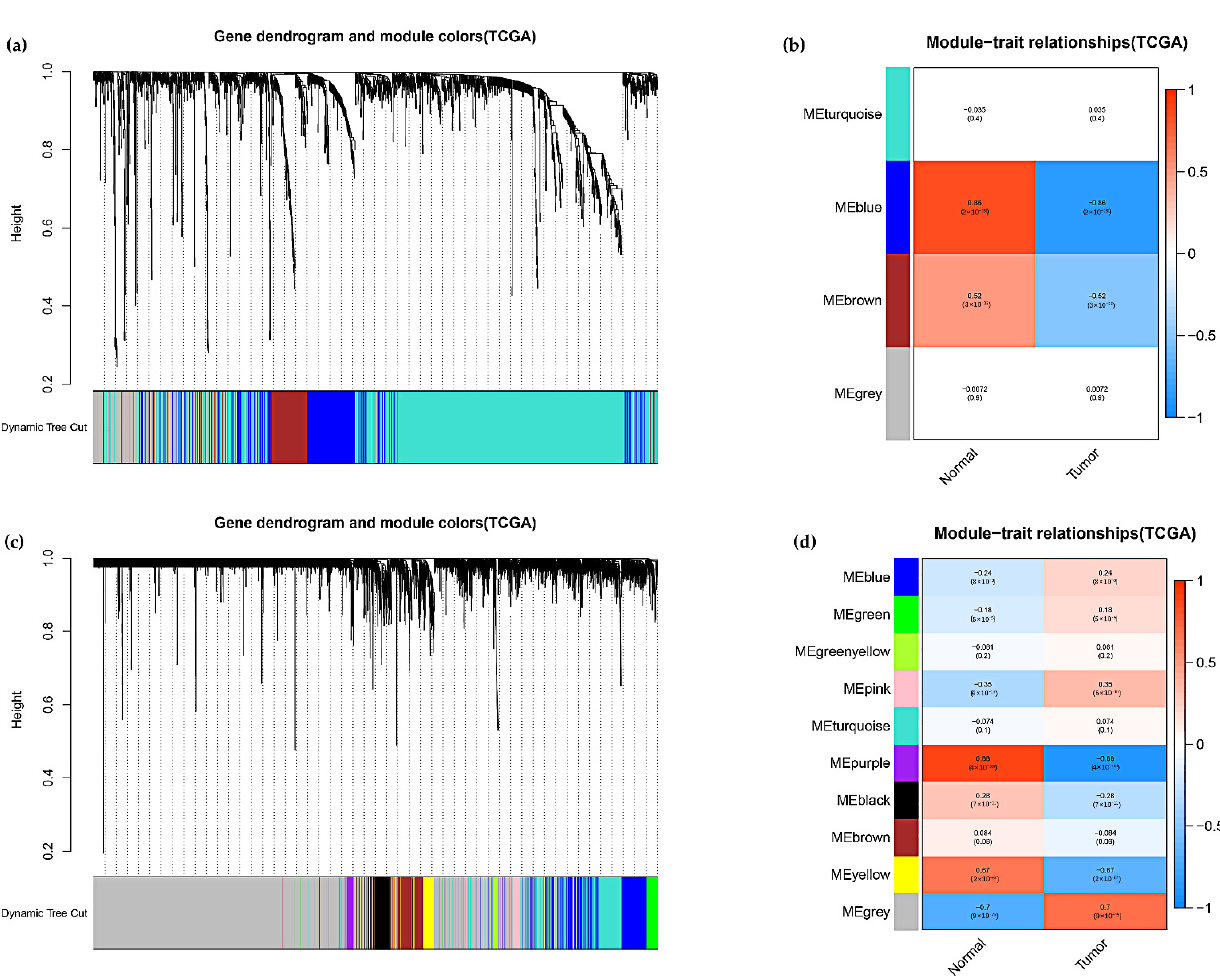
Figure 7. Screening for modules significantly associated with colon adenocarcinoma by WGCNA. ( a ) Hierarchical cluster analysis of the identified lncRNAs was performed to detect co-expression clusters with corresponding color assignments. ( b ) Correlation analysis of clinical features of colon adenocarcinoma with Eigengene of lncRNAs, where MEblue had the highest correlation coefficient. ( c ) Hierarchical clustering analysis of the identified mRNAs. ( d ) Correlation analysis of clinical features of colon adenocarcinoma with Eigengene of mRNAs, where MEpurple had the highest correlation